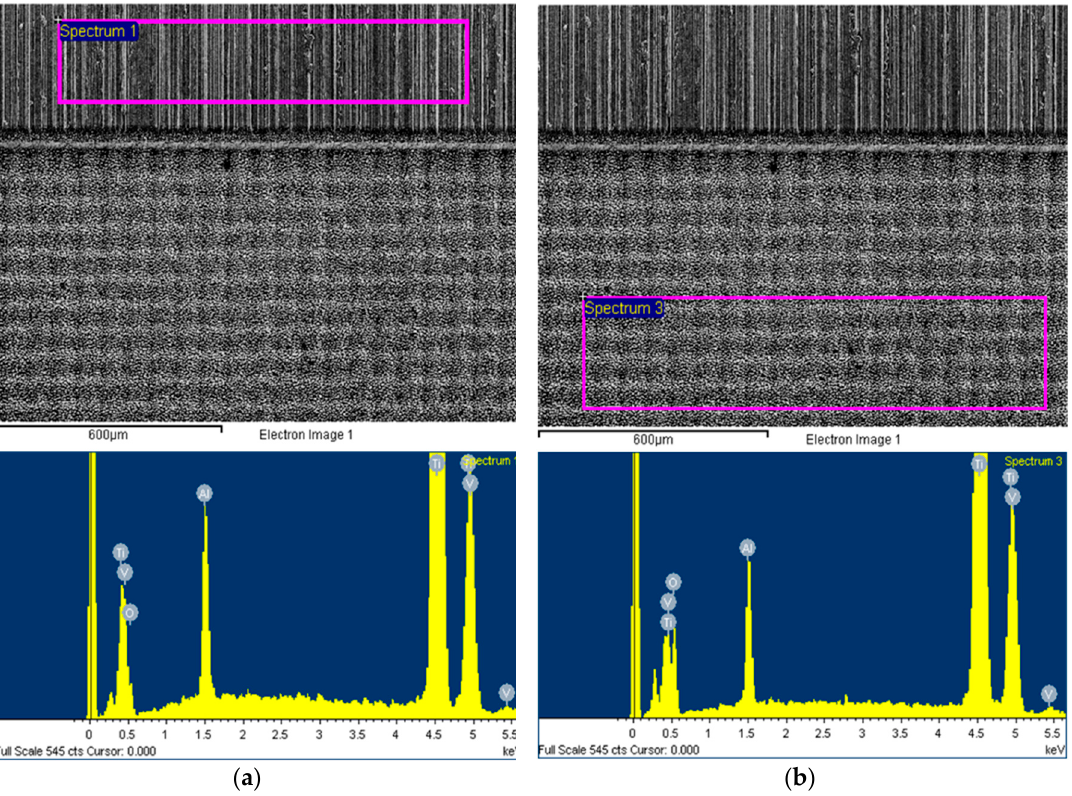
Figure 11. EDS analysis of the Titanium Grade 23 substrate considering ( a ) a surface without laser treatment (Spectrum 1, O: 0 wt %) and ( b ) a surface where laser texturing process was performed (Spectrum 3, O: 23 wt %).